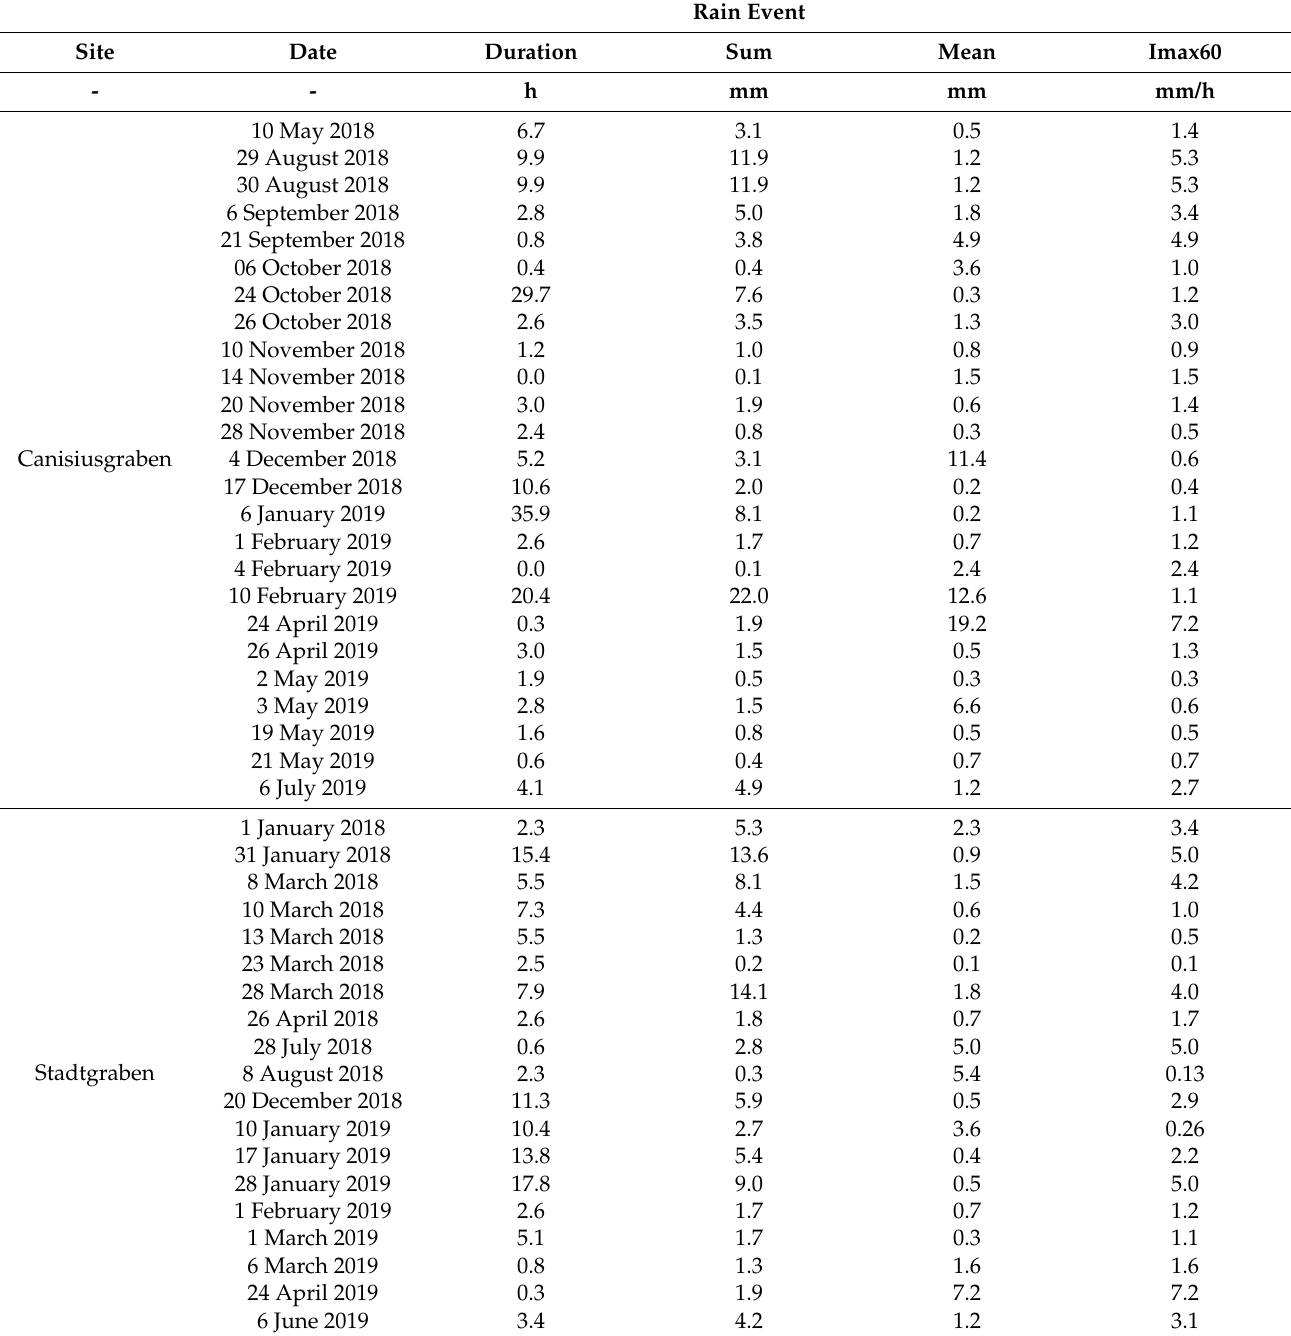
Table A1. Rain statistic for events covered by automatic